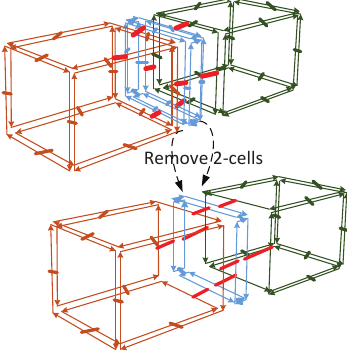
Figure 11. Remove 2-cells to merge adjacent 3-cells Algorithm 1 implements the key step of merging adjacent 3-cells